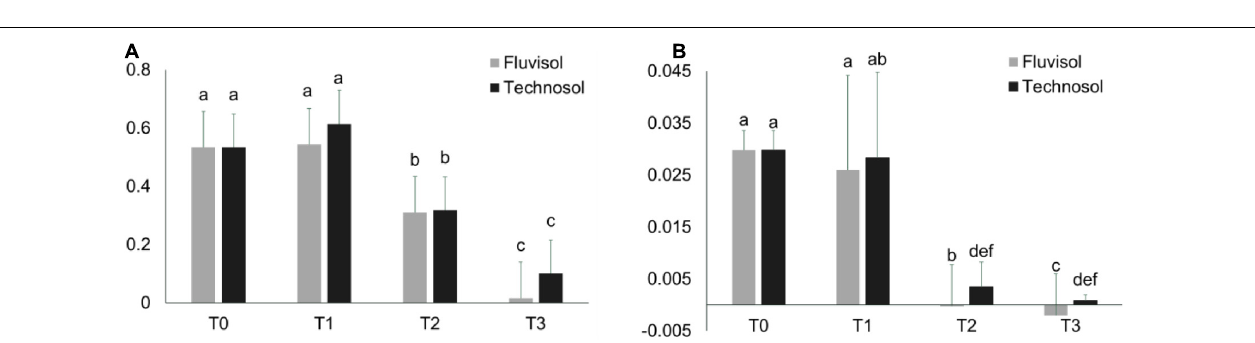
FIGURE 5 | The NDVI (A) and PRI (B) indexes evaluated during the microcosm assay in different reference periods (mean ± SD; n = 15). T0, transplantation, in winter; T1, Spring; T2, Summer; and T3, Autumn. Different letters meaning significant differences ( p < 0.05, two-way ANOVA (time × substrata) followed by Tukey HSD